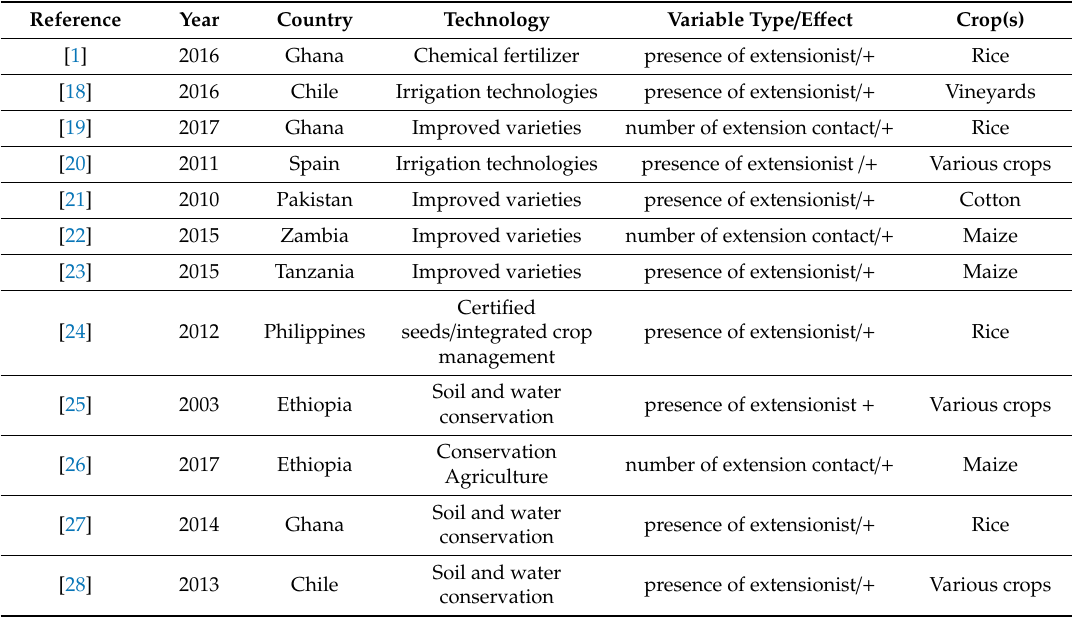
Table 1. Summary of key features and the association between extension and technology